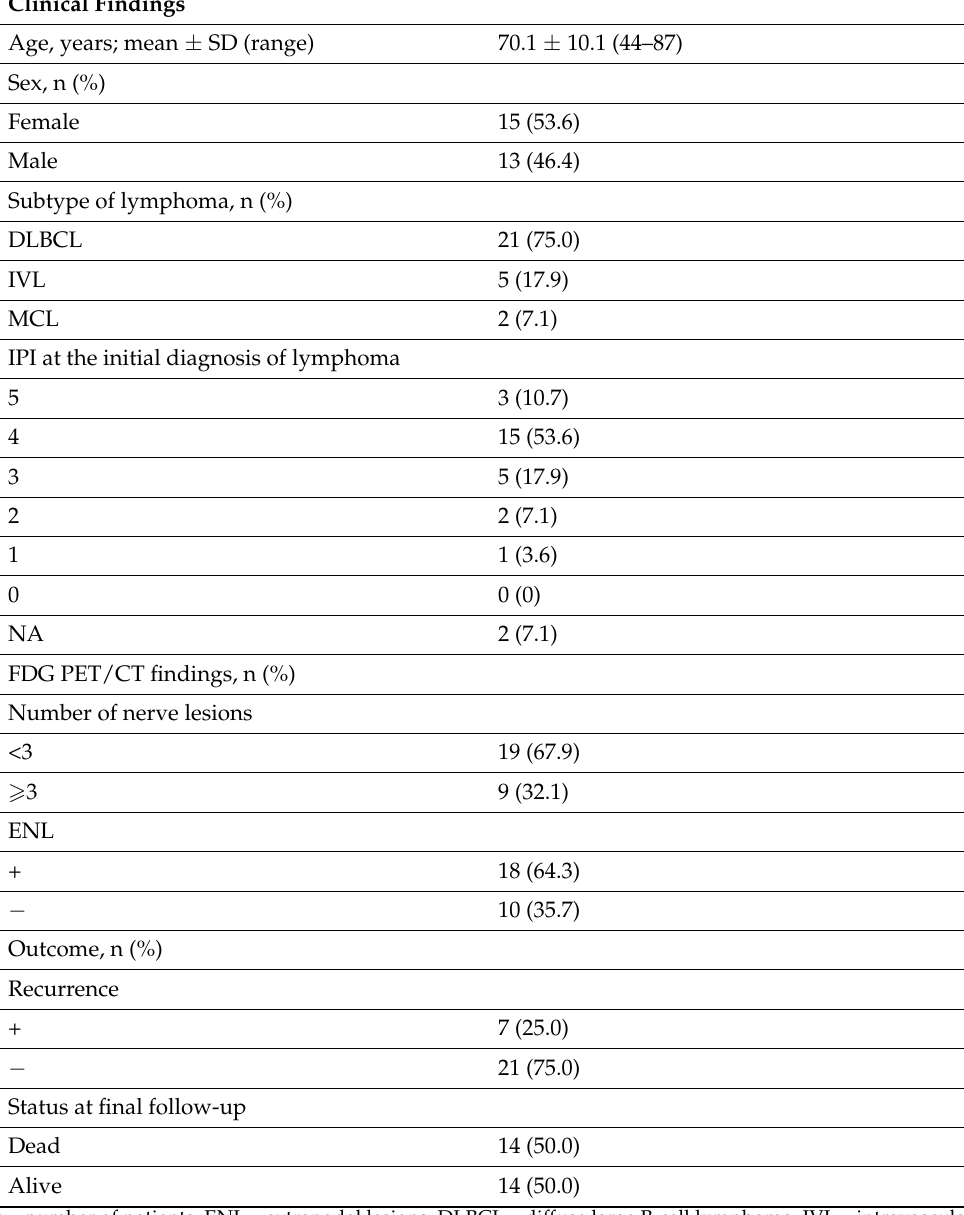
Table 1. Clinical characteristics of all 28